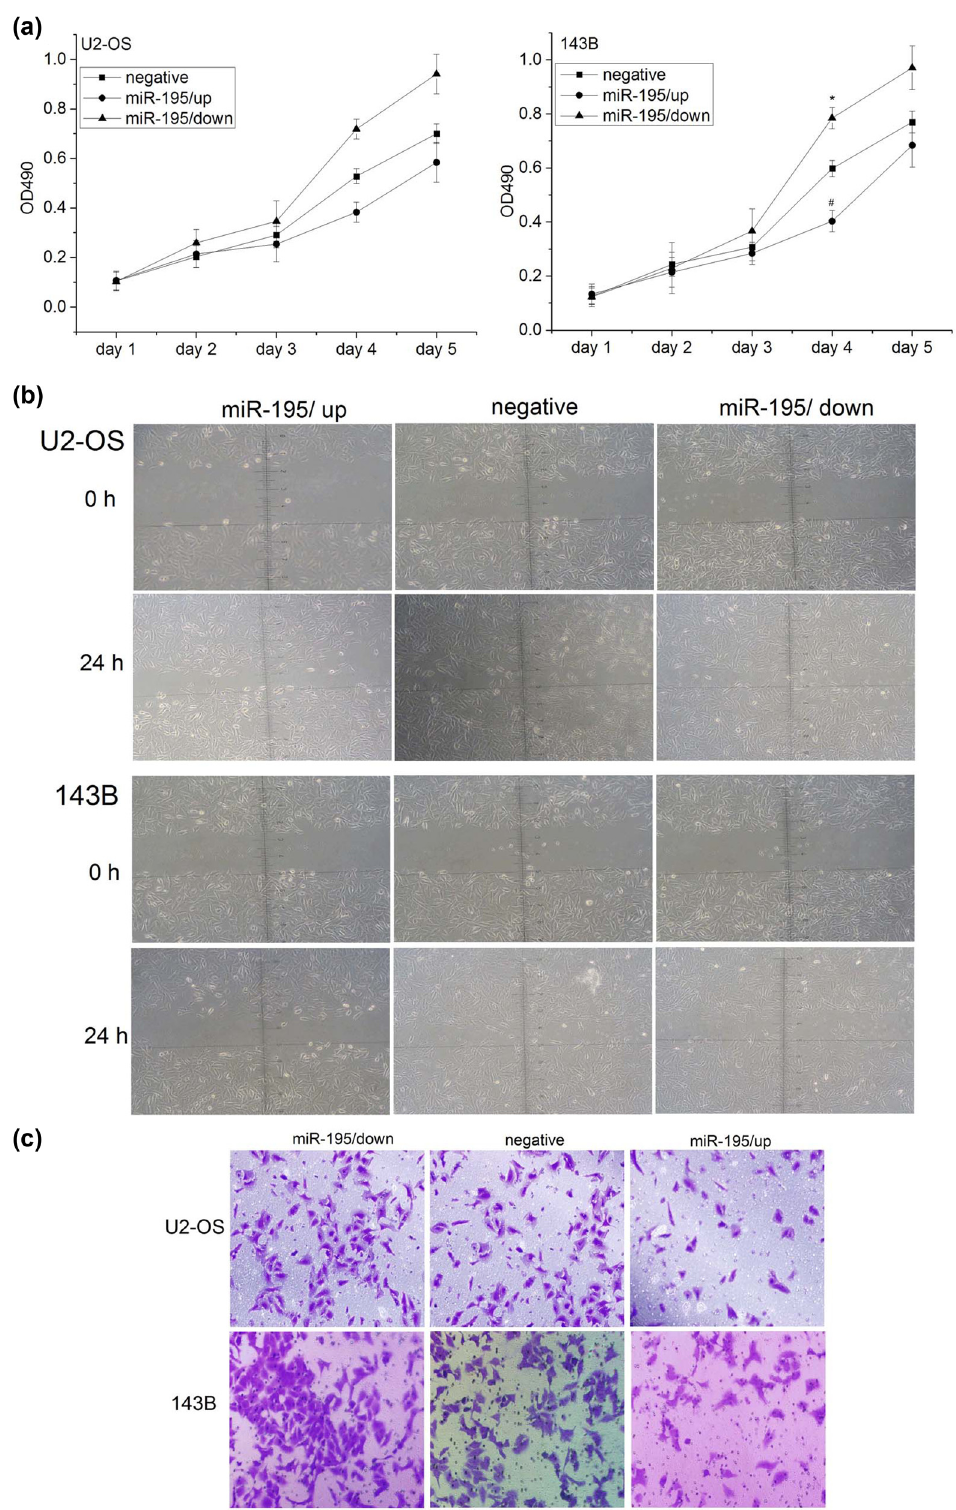
Figure 3: miR - 195 inhibited cell proliferation, cell migration, and invasion in osteosarcoma. ( a ) The proliferation activity of osteosarcoma cells was detected by MTT assay. Left: the proliferation ability of U2 - OS cells was signi fi cantly decreased in the group miR - 195/up ( n = 6; day 4: * p < 0.001 ) and signi fi cantly increased in the group miR - 195/down in vitro ( n = 6; day 4: # p < 0.001 ) . Right: the proliferation ability of 143B cell was signi fi cantly decreased in the group miR - 195/up ( n = 6; day 4: * p < 0.001 ) and signi fi cantly increased in the group miR - 195/ down in vitro ( n = 6; day 4: # p < 0.001 ) . The error bar represents the standard variation of the OD490 in the U2 - OS or 143B cells transfected with lentiviruses overexpressing or inhibiting miR - 195. ( b ) The migration ability of osteosarcoma cells at 24 h using wound healing assay was signi fi cantly decreased in the group miR - 195/up ( n = 6, × 200 ) . ( c ) The invasion ability of osteosarcoma cells at 24 h using Transwell invasion assay was signi fi cantly decreased in the miR - 195/up group and signi fi cantly increased in the miR - 195/down group ( n = 6, × 200 )